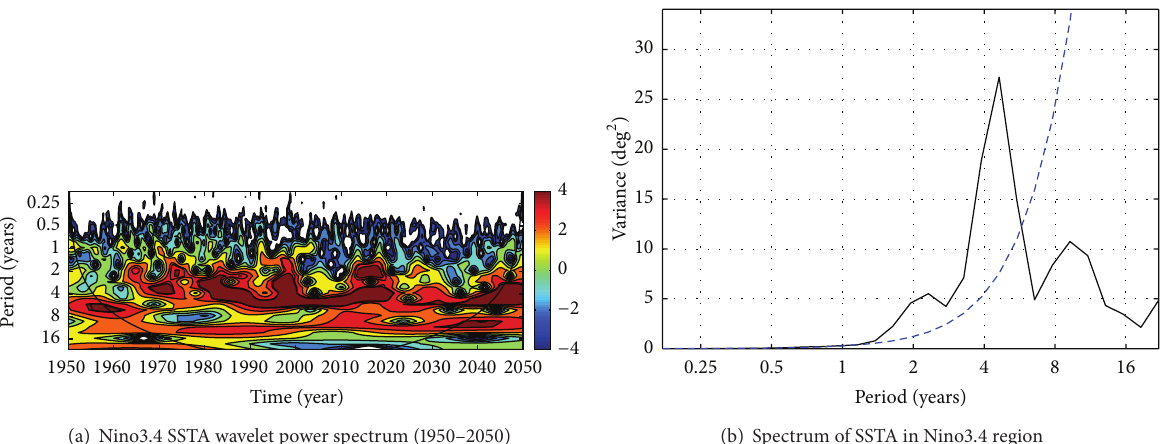
Figure 6: The evolution of the difference of the sea level pressure anomaly ( Δ SLP) between East Pacific (80 ∘ E-160 ∘ E, 5 ∘ S-5 ∘ N) and West Pacific (160 ∘ W-80 ∘ W, 5 ∘ S-5 ∘ N) and zonal wind stress anomaly in equatorial Pacific (120 ∘ E-70 ∘ W, 5 ∘ S-5 ∘ N) since the 20th century from IPCC- AR4IPCC-AR4 data.